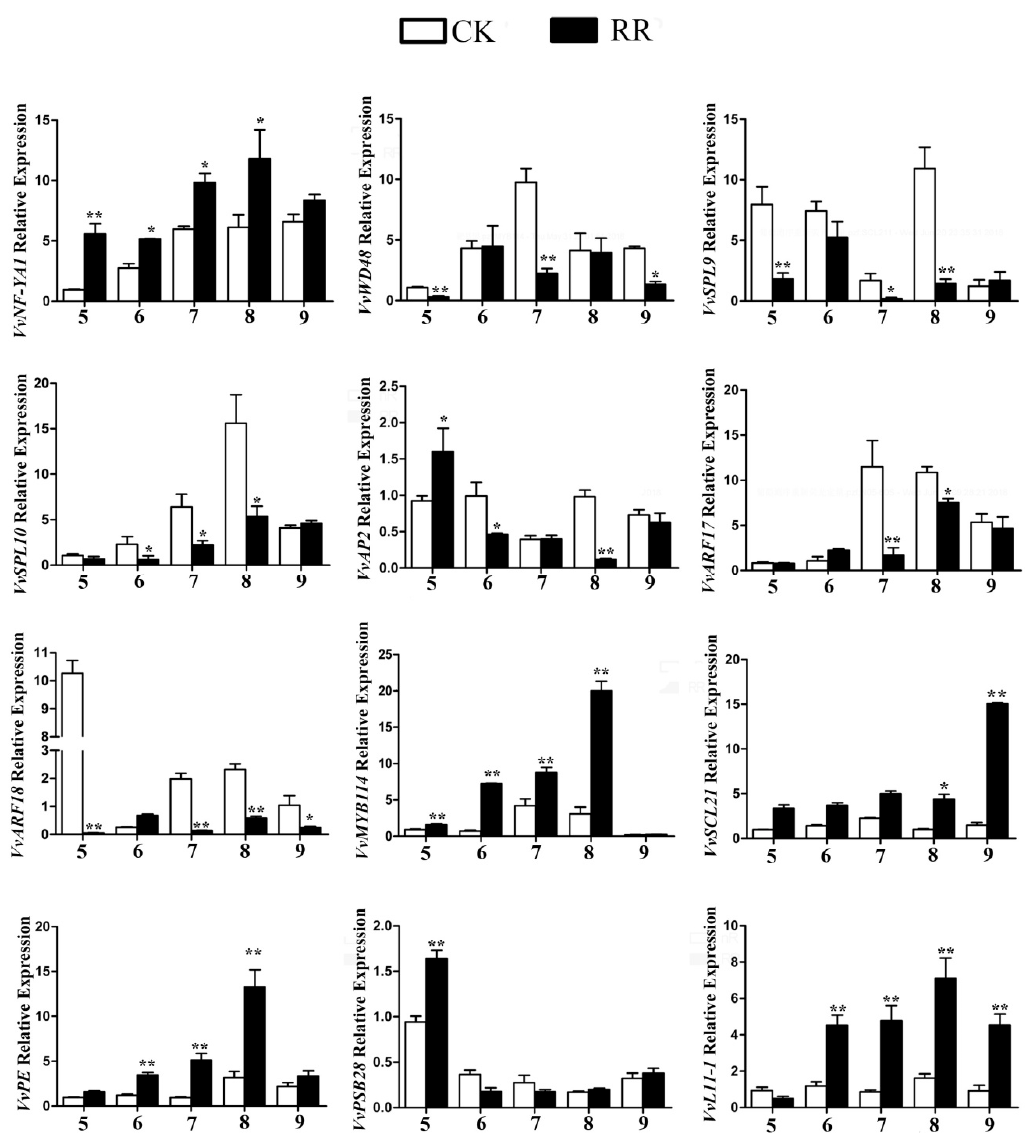
Figure 7. qRT-PCR analysis of target genes of selected differentially expressed miRNAs. VvPE (XM_002266944.4), VvPSB28 (XM_002271630.4), and VvL11-1 (XM_002270230.4). * p < 0.05 and ** p < 0.01, respectively, according to two-tailed Student’s t -test. Error bars show the standard error between three biological replicates ( n = 3). 5–9 indicate that the sample collection time 14 July, 18 July, 23 July, 1 August, and 9 August 2017, respectively.